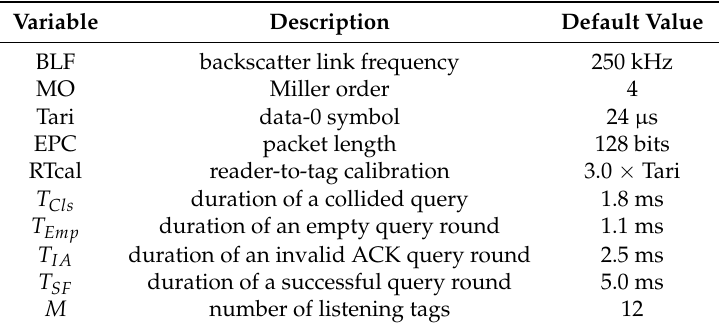
Table 1. Setting of the simulation parameters.